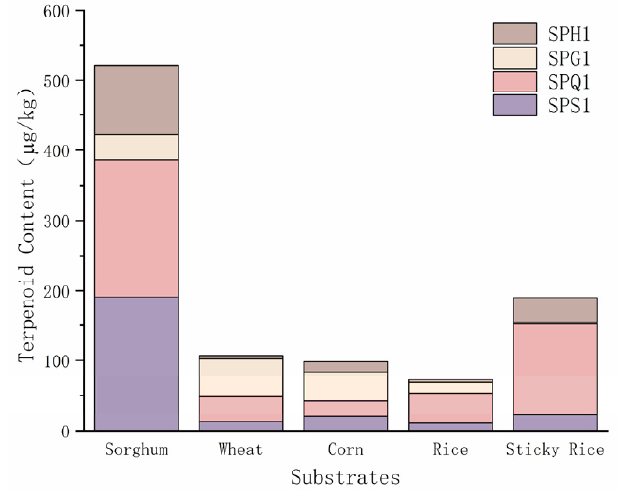
Figure 1. Content of terpenoid products from liquid-state fermentation of different types of sub- strates.